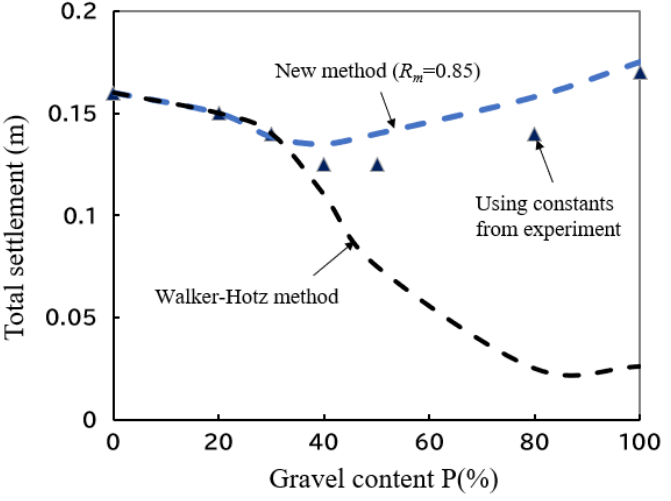
Figure 14. Total settlement after construction of embankment.